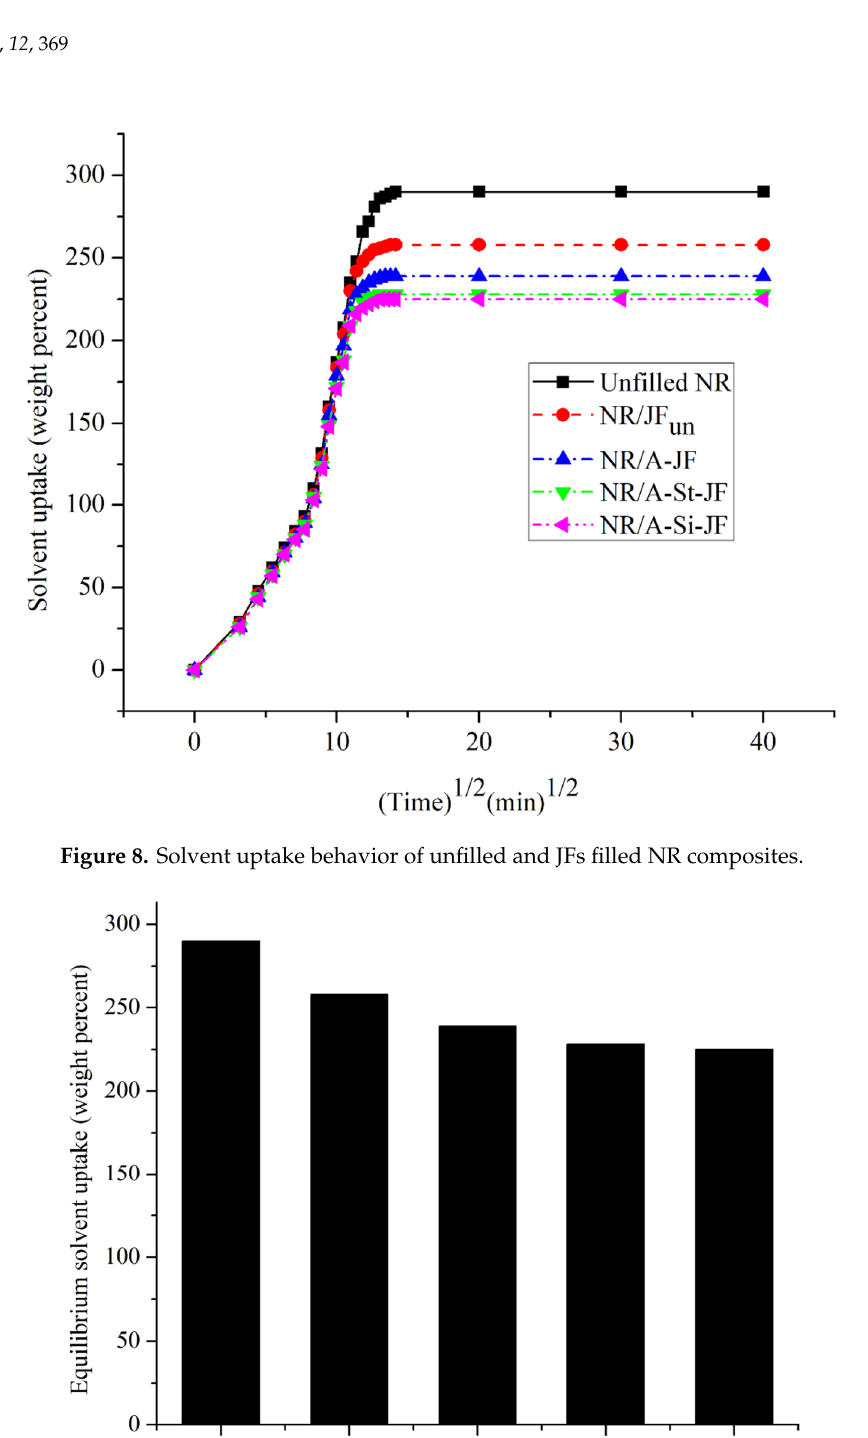
Figure 9. The values of equilibrium solvent uptake of different NR composites.